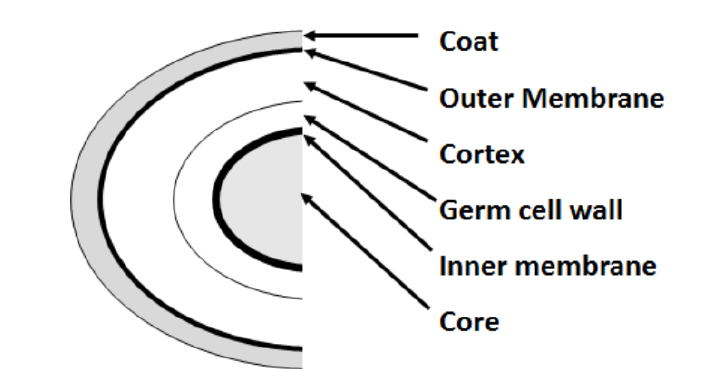
Figure 1. A schematic representation of the layers of a bacterial spore belonging to the Bacillus genus. The external coat is a protein layer that surrounds the outer lipid membrane; below this membrane, two peptidoglycan layers i.e., where the cortex and the germ cell wall coat are located. The inner membrane (in which different proteins acting as germination receptors and channels mediating the exchange of molecules and ions) surrounds the spore core where DNA and proteins are suspended in a Ca 2 + -DPA that act as a protection against harmful chemical or physical